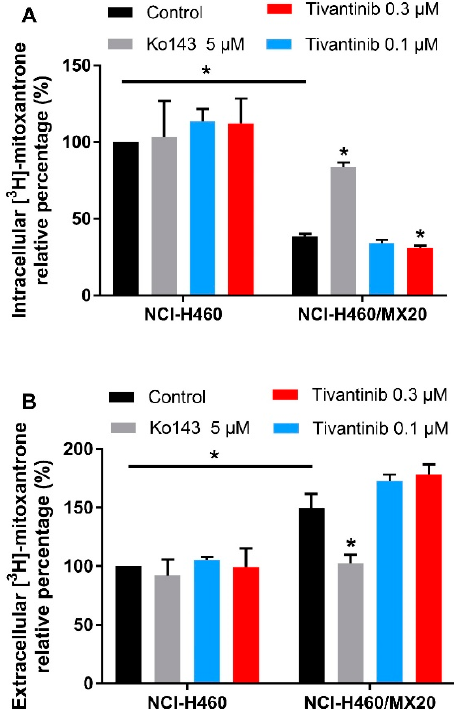
Figure 5 . The effect of tivantinib on the accumulation of [ 3 H]-mitoxantrone after 72 h treatment. ( A ) The effect of tivantinib on the intracellular accumulation of [ 3 H]-mitoxantrone in NCI-H460 and NCI-H460 / MX20 cells after 72 h treatment. ( B ) The relative percentage of [ 3 H]-mitoxantrone in the medium after 72 h tivantinib treatment in NCI-H460 and NCI-H460 / MX20 cells. The percentages were calculated as the treatment groups divided by the parental control group. Data are expressed as the mean ± SD from a representative of three independent experiments. * p < 0.05, compared with the control group.